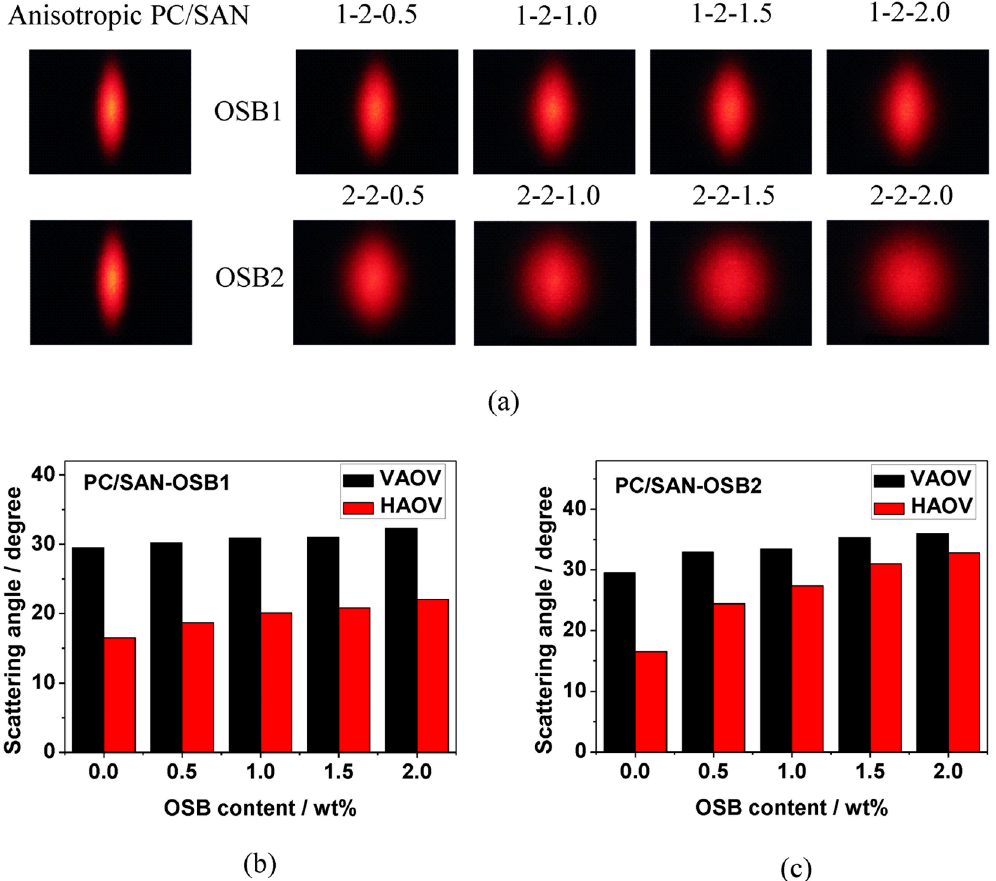
Figure 7. ( a ) Scattering patterns of two groups with OSB mass fraction increasing from 0 to 2.0 wt%, the draw ratio is 2. ( b ) and ( c ) Scattering angle of two groups with OSB mass fraction increasing from 0 to 2.0